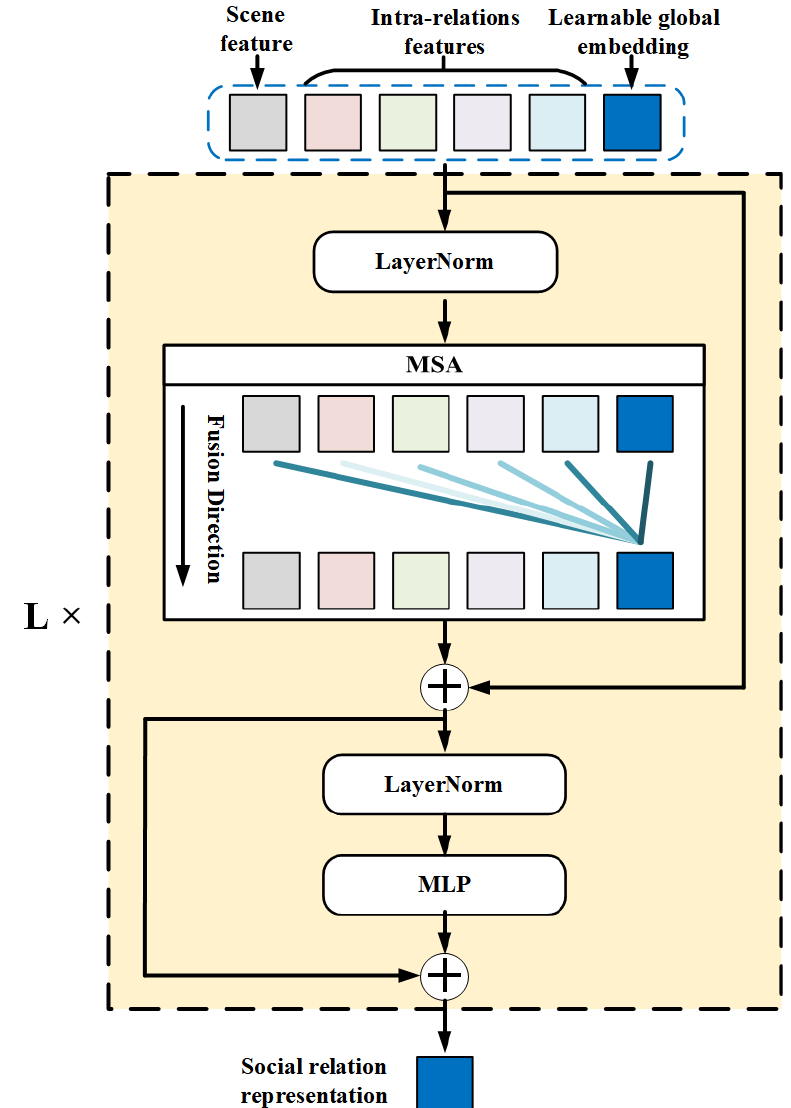
Figure 4. Intra-TRM module. For one person pair, the inputs are all the extracted features along with a learnable global embedding. With the MSA in stacked transformers, global embedding gradually fuses the various features with different